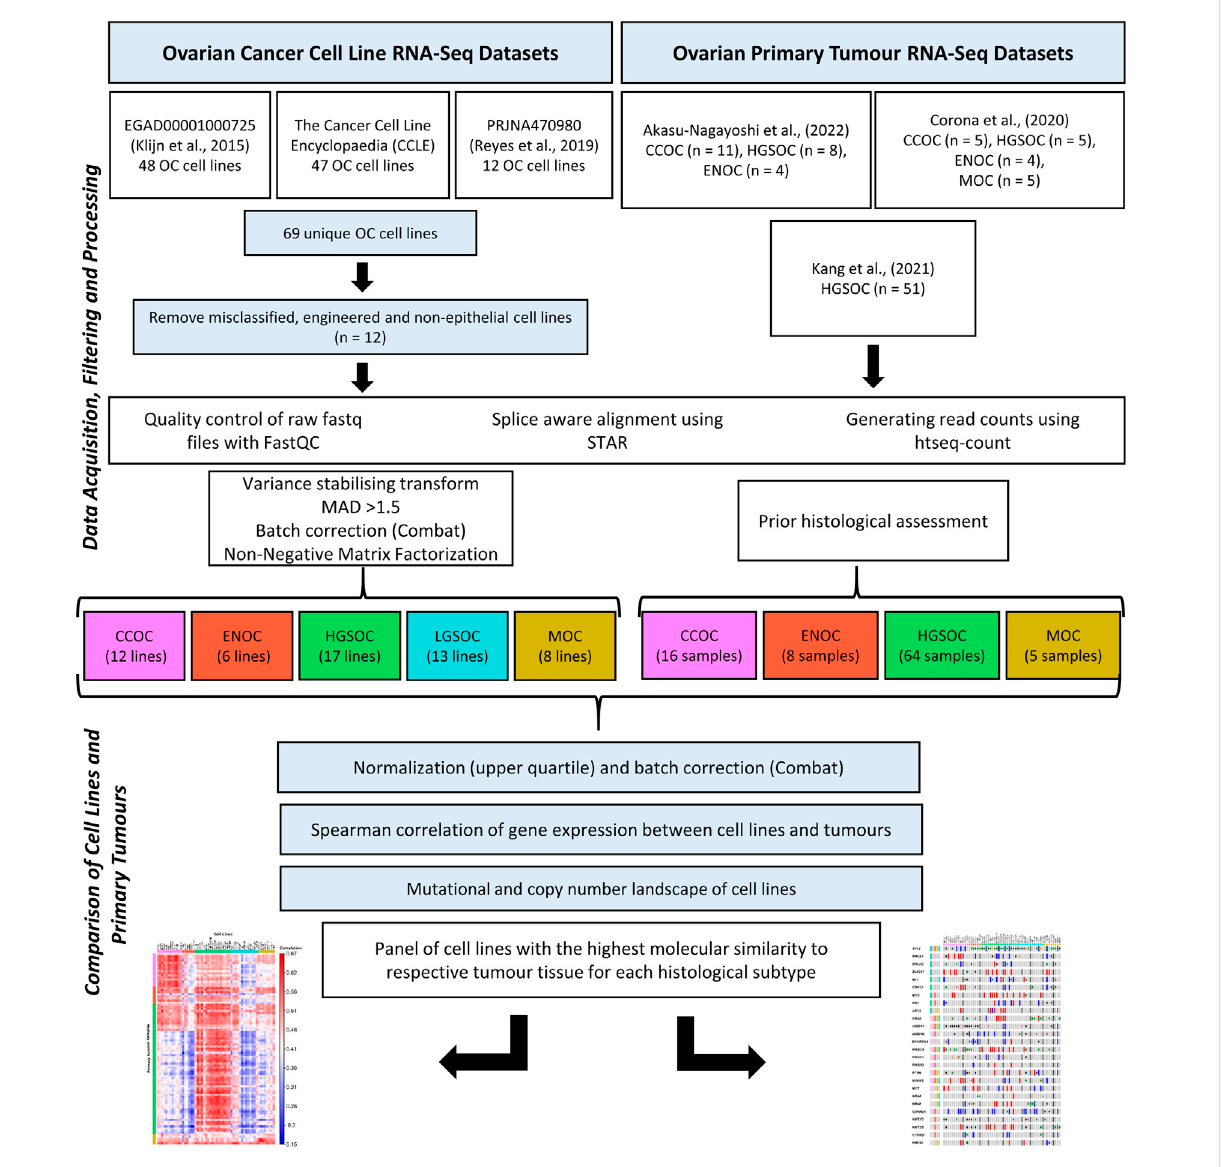
FIGURE 1 Transcriptomic data for 56 EOC cell lines and 93 primary tumor samples were processed using the same bioinformatics pipeline. NMF was used to stratify the cell lines into putative histological subtypes while patient samples had undergone histological assessment. Mutations and copy number variations of cell lines were investigated to identify the lines most similar to EOC tumor subtypes, as delineated in the literature. Correlation analysis was also carried out on the cell line and tumor gene expression data to assess similarity between the two